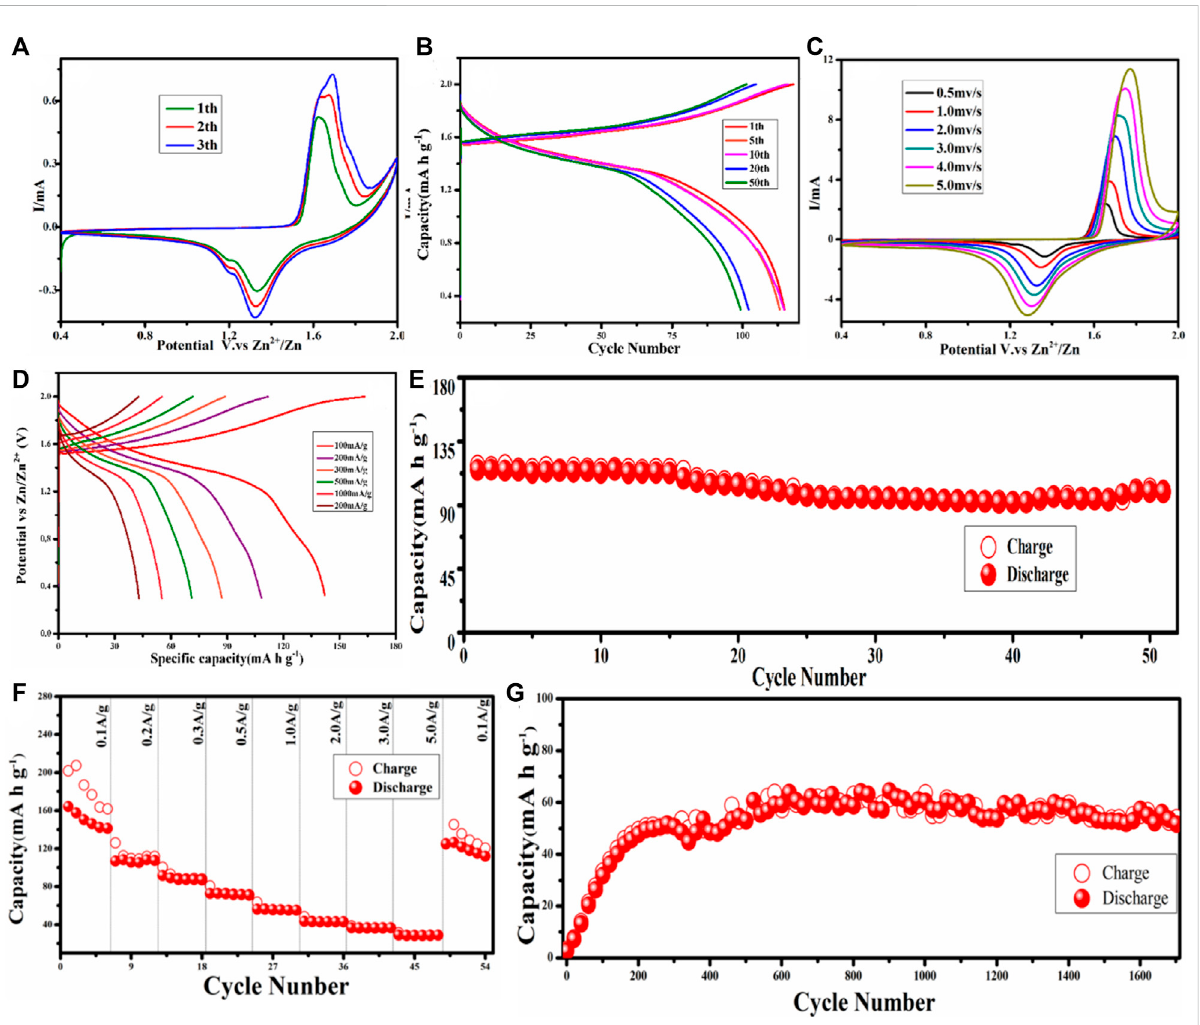
FIGURE 3 (A) CV curves of the fi rst three cycles of MnCO 3 at 0.5 mV/s. (B) Galvanostatic charge – discharge (GCD) curves under different cycles. (C) CV curves of